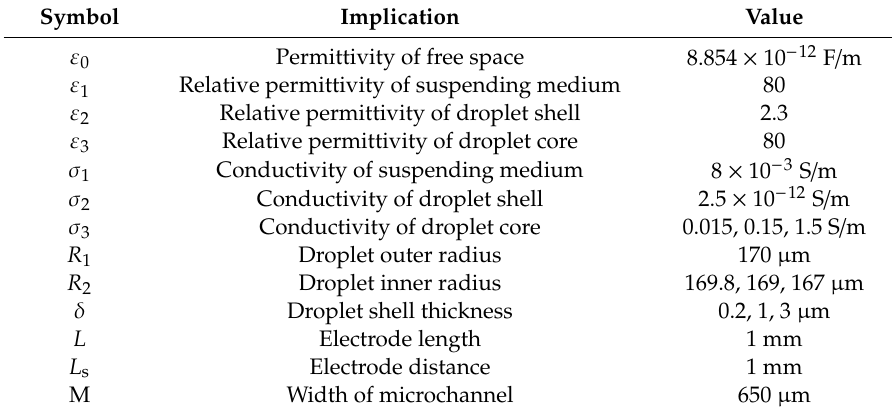
Figure 2. Calculation of Clsusius–Mossotti factor as a function of field frequencies. ( A ) The core-shell model for double emulsions; ( B ) CM factor plot with varying shell thickness, σ 3 = 1.5 and σ 1 = 0.008; ( C ) CM factor plot with varying core conductivity, σ 1 = 0.008 and δ = 200 nm. Table 1. Parameters and dimensions used in the modeling